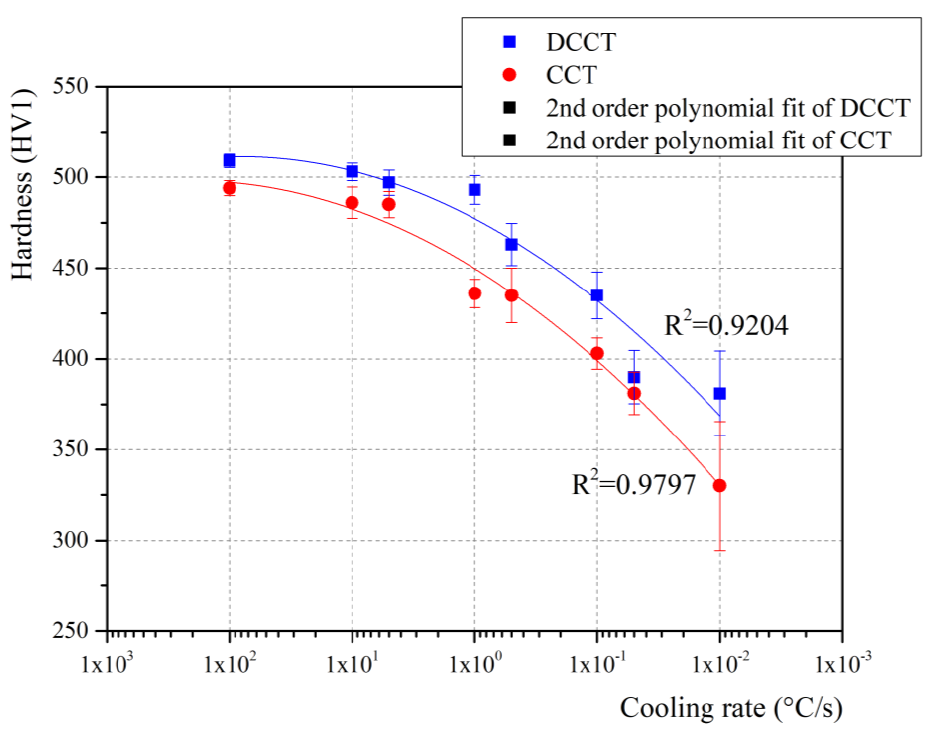
Figure 11. Hardness results for the CCT and DCCT samples cooled at different cooling rates.